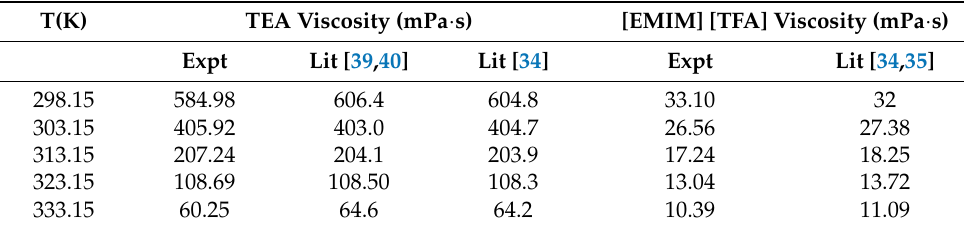
Table 1. Comparison of the viscosity between experiment and literature data a,b .